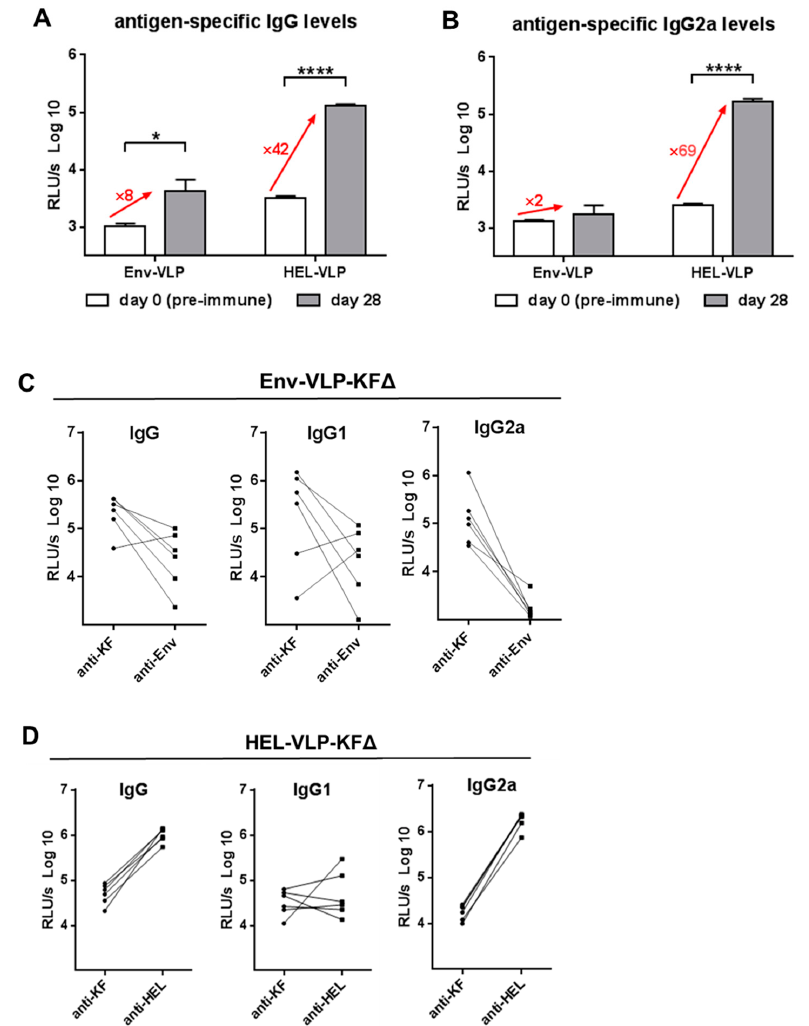
Figure 5. Immunogenicity balance between different envelope proteins of HIV-based nano-vaccines. (A, B) Wt mice were immunized with Env-VLP (Balb/c) or HEL-VLP (C3H) in total amount of 400 ng antigen/mouse. 28 days after the single immunization total IgG ( A ) and IgG2a ( B ) humoral responses against corresponding antigens were measured in 1:100 diluted sera samples and expressed as log10- transformed relative light units per second (RLU/s log10). The columns represent the mean values ± SEM ( n = 6). * p = 0.0329; **** p < 0.0001; two-tailed paired t -test. Fold of increase in the signal intensity (numbers in red) was calculated for each individual mouse ( n = 6) as ratio: (Untransformed signal at day 28)/(untransformed signal at day 0). Means of six values are present. ( C, D ) Data represent humoral immune responses against KF vs. HIV-Env ( C ) and KF vs. HEL ( D ) in the individual Balb/c ( C ) and C3H ( D ) mice at day 49 (2 weeks after the second immunization with Env-VLP-KF Δ ( C ) or with HEL-VLP-KF Δ ( D )).